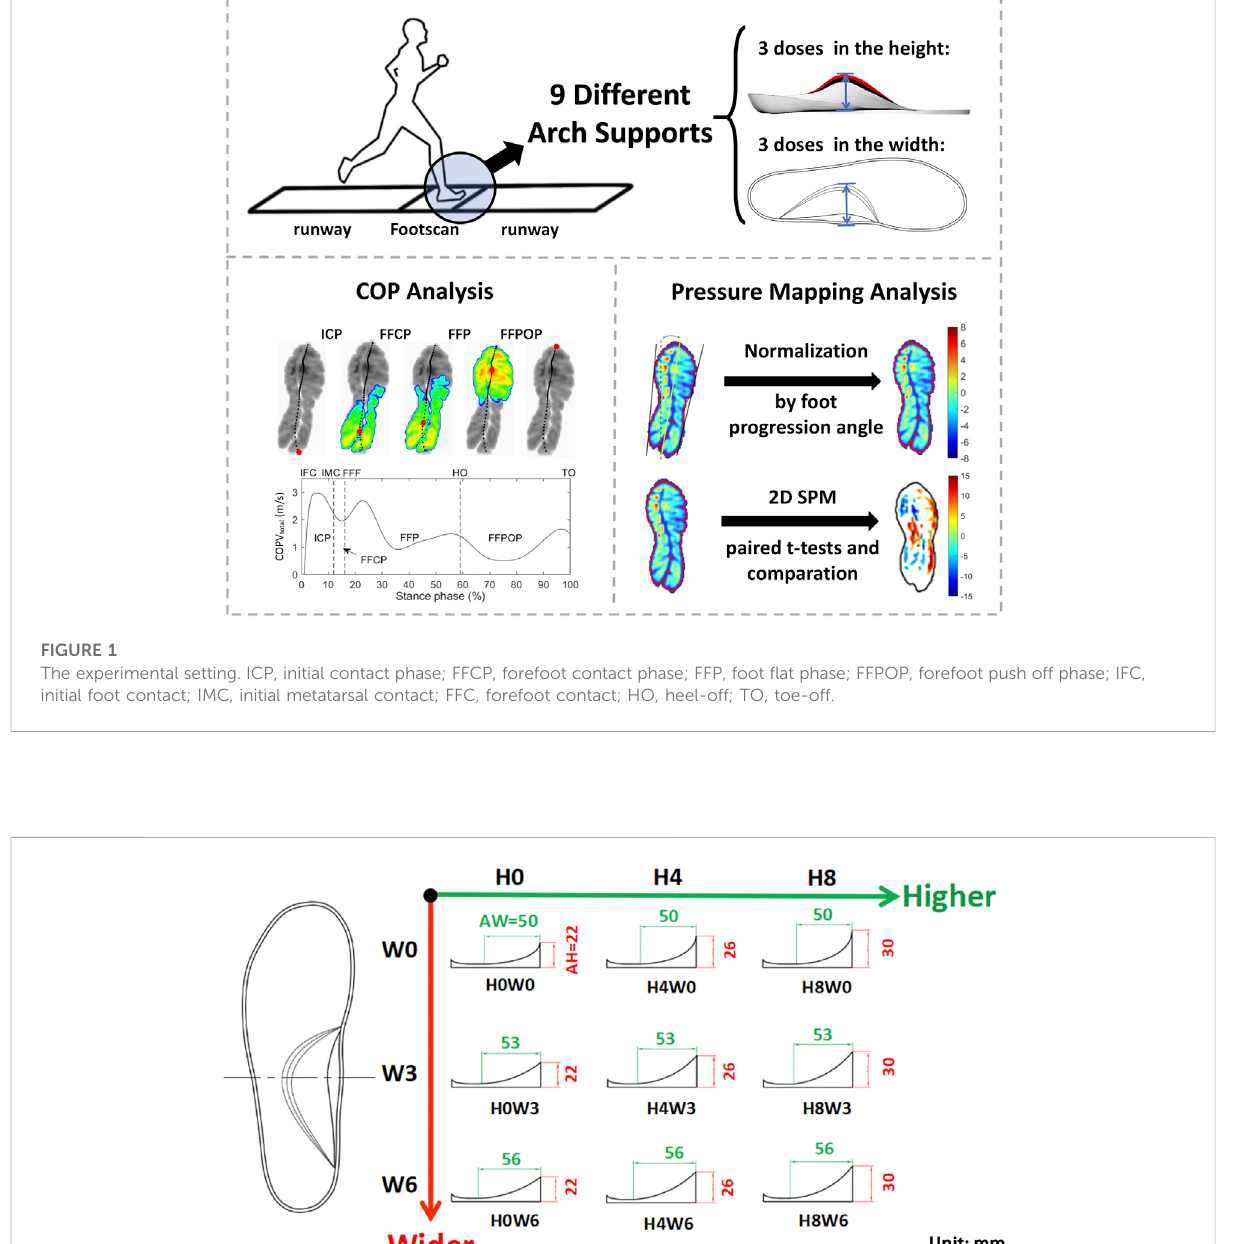
Frontiers in Bioengineering and